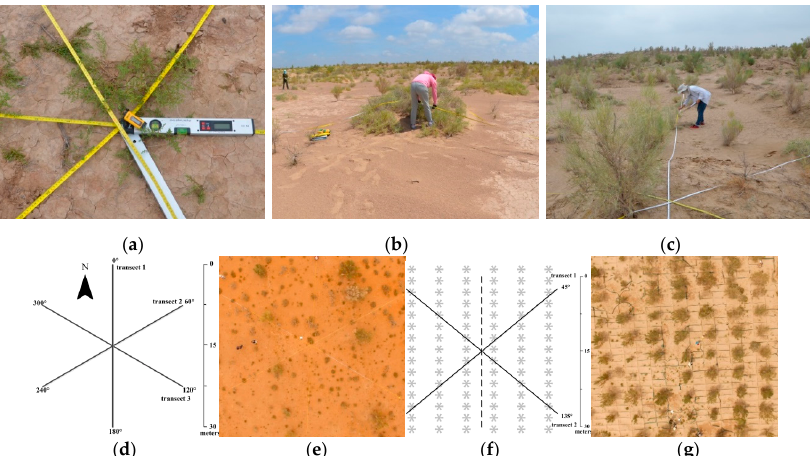
Figure 2. Field observations. ( a ) Recording central location by Global Positioning System (GPS); ( b , c ) field measurements of vegetation fractional cover; ( d ) transect layout in natural or pastoral environments; ( e , g ) field-observation-site images taken by unmanned aerial vehicle (UAV) from natural environment and artificial vegetation in rows, respectively; ( f ) transect layout in artificial vegetation in